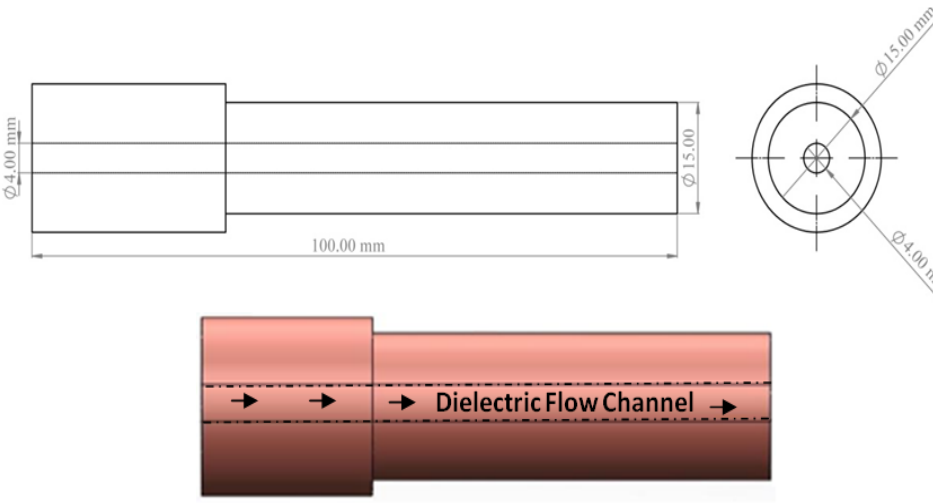
Figure 2. Copper electrode with inner hole for dielectric flushing.